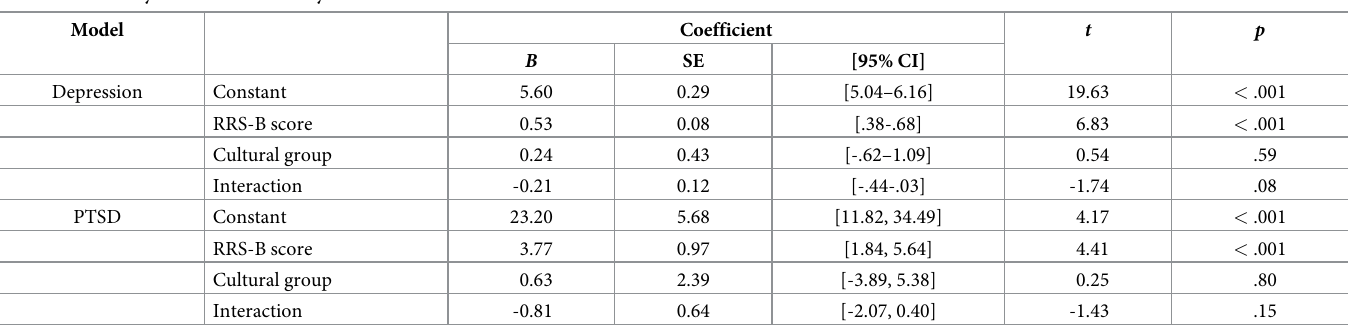
Table 2. Summary of moderation